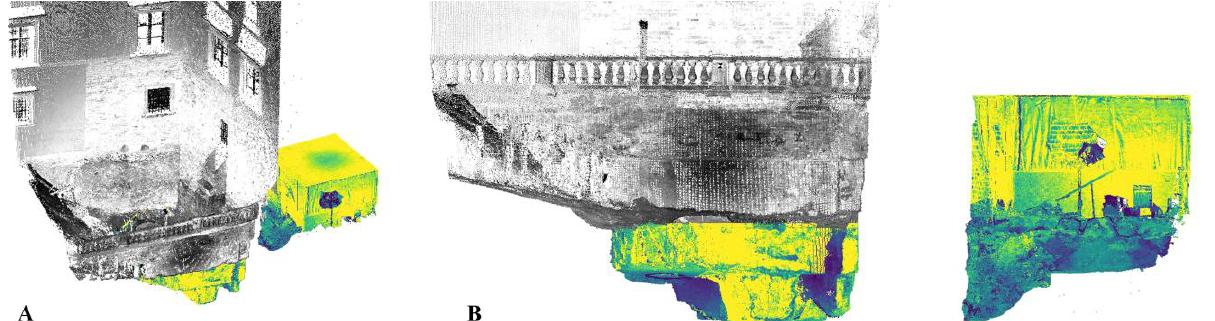
Figure 9. Example clouds of points used in analysing the thickness and the state of preservation of the Justice Court Tower’s walls